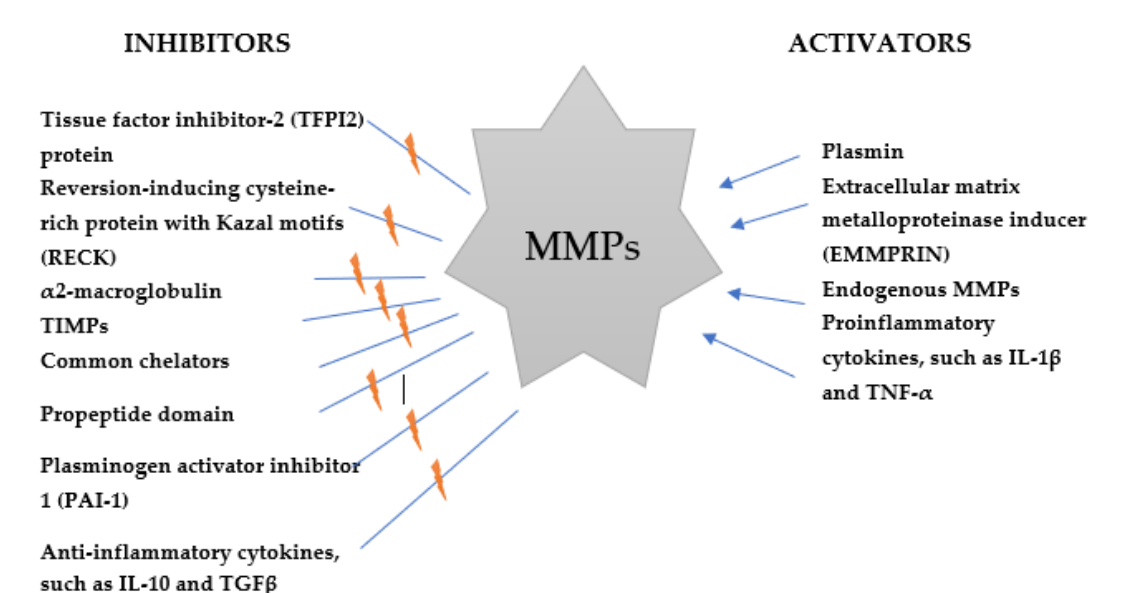
Figure 2. Selected inhibitors and activators of matrix metalloproteinases (MMPs).